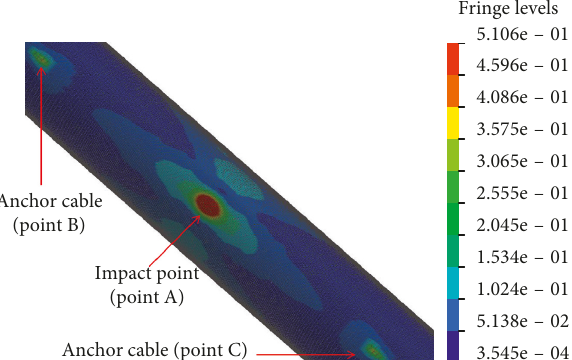
Figure 18: Nephogram of stress along the tunnel at 0.59 s.